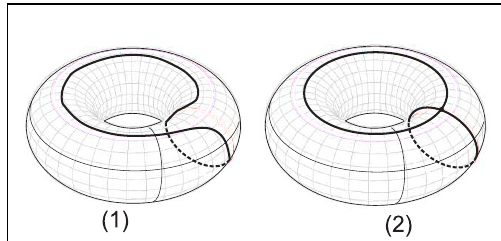
Figure 5. Characteristic Curve on torus in Case 1 and Case 2.